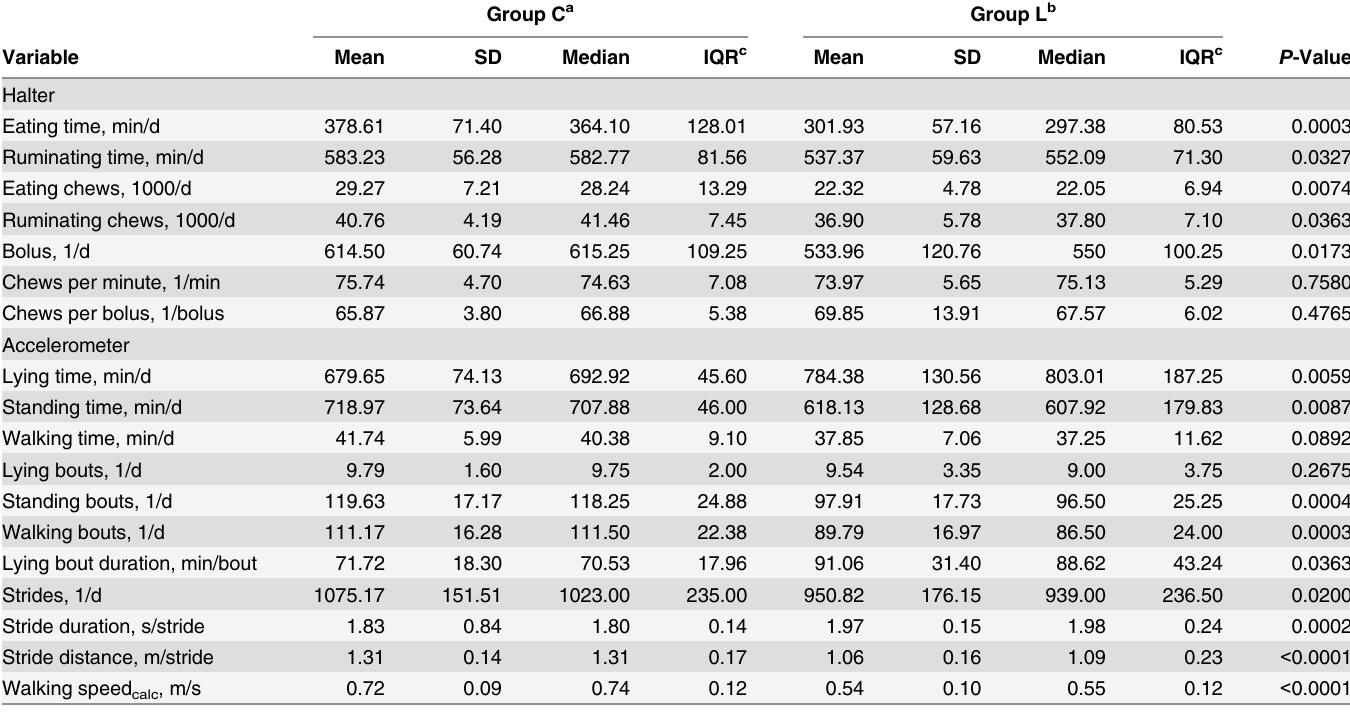
a Group C: Non-lame = Numerical rating system (NRS) according to Flower and Weary [38] (cid:3) 2. b Group L: lame = NRS (cid:1) 2.5. c Interquartile